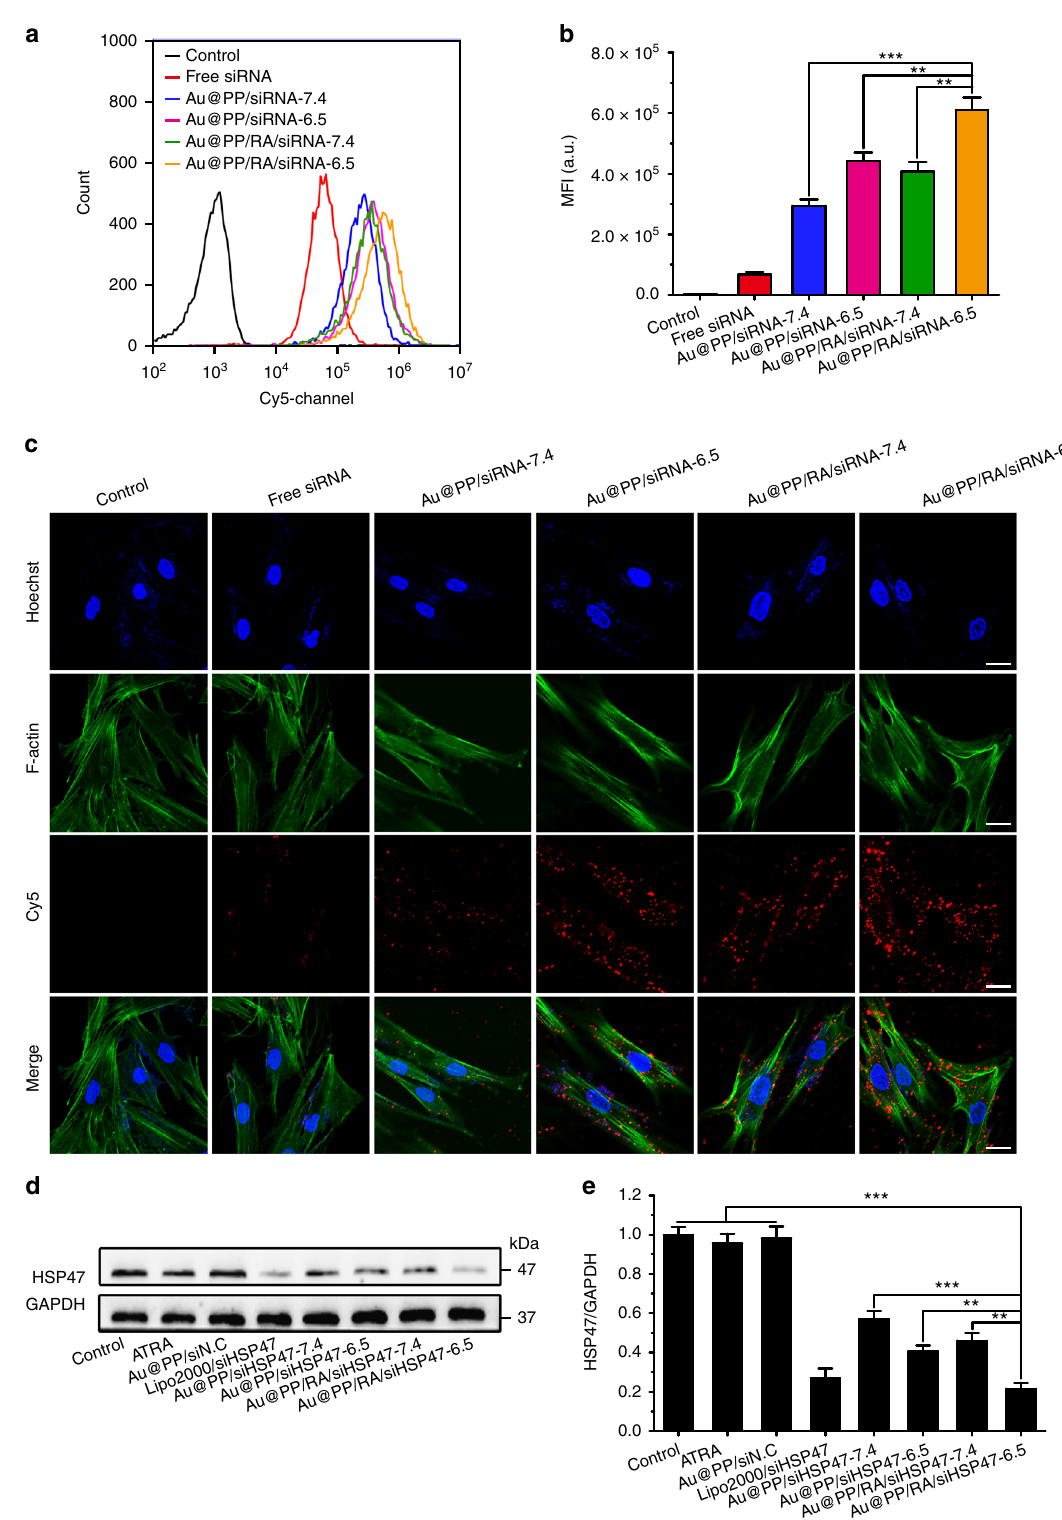
Fig. 3 pHe and ATRA dual-enhanced cellular uptake and gene silencing. a Flow cytometry analysis of PSCs after incubation with Cy5-siRNA-loaded Au@PP or Au@PP/RA at pH 7.4 or 6.5 for 2 h. b The mean fl uorescence intensity (MFI) of the different groups. The data are shown as the mean ± s.d. ( n = 3). ** p < 0.01, *** p < 0.001 (Student ’ s t test). c Confocal laser scanning microscopy images of PSCs after incubation with Cy5-siRNA (red) loaded formulations at pH 7.4 or 6.5 for 2 h. F-actin was labelled with phalloidin (green) and nuclei were labelled with Hoechst 33342 (blue). Scale bars, 20 μ m. d Western blot analysis of HSP47 protein in PSCs after treatment with the indicated formulations for 48 h at pH 7.4 or 6.5. Lipofectamine 2000 transfection agent served as a positive control (Lipo2000/siHSP47). siN.C, negative control siRNA; siHSP47, HSP47 siRNA. e Quantitative analysis of the normalised HSP47 protein expression (using Image J software). The data are shown as the mean ± s.d. ( n = 3). ** p < 0.01, *** p < 0.001 (Student ’ s t